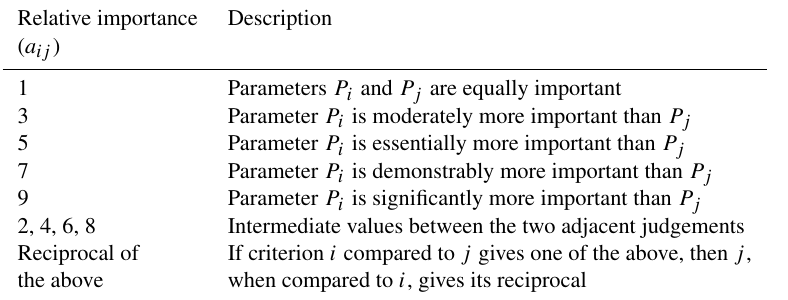
Table 4. Scale of relative importance of the secondary parameters (Saaty,